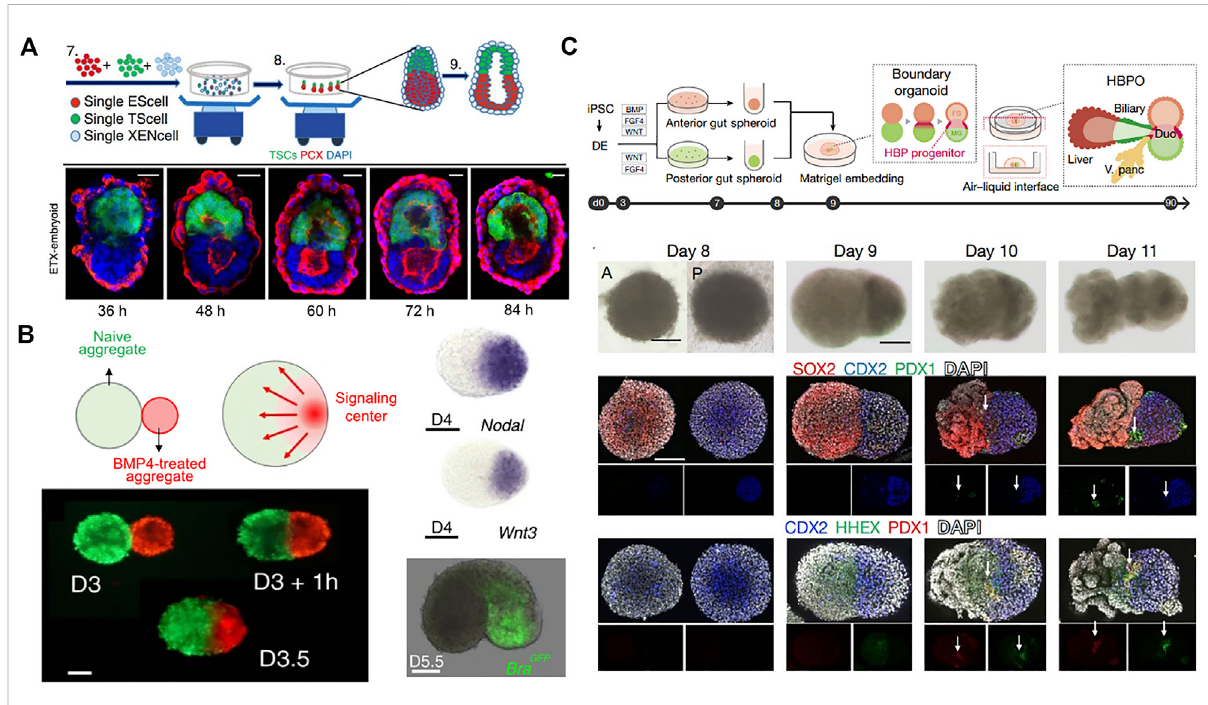
FIGURE 5 Guided morphogenesis by initial cellular assembly. (A) Schematic overview of generation of self-assembled ETX-embryoids from a combination of ESCs, TSCs, and XENCs and immuno-stained images showing the progression of pro-amniotic cavity formation. Adapted from ref. (Zhang et al., 2019). (B) BMP4-instructred (red) and untreated mESC aggregates (green) merged spontaneously forming an embryoid. BMP4 activation led to restricted expression of Wnt3 and Nodal in the signaling center, which induced expression of the mesoderm and primitivestreakmarker,brachyury(Bra).Adaptedfromref.(Xuetal.,2021). (C) SchematicoverviewofgenerationofHBPorganoidbymerginghiPSC- derived anterior and posterior gut spheroids. Bright- fi eld and whole-mount immuno-stained images for SOX2 (anterior cut cells), CDX2 (posterior gut cells), PDX1 (pancreas progenitor), and HHEX (early hepatic marker).HHEX and PDX1 were detected only attheboundary of thefused spheroids. Adapted from ref. (Koike et al., 2019). Scale bars, (A) 20 μ m and (B,C) 100